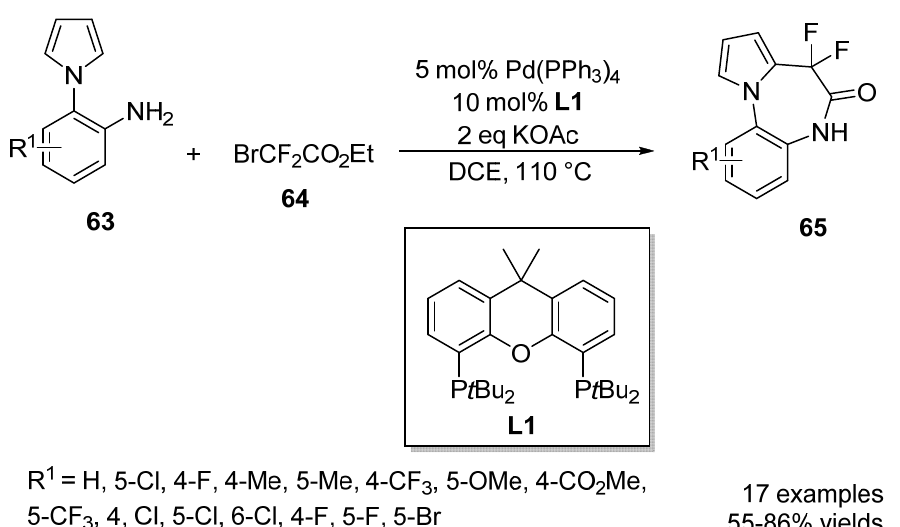
Scheme 30. Cascade reaction for the synthesis of difluoroalkylated pyrrolobenzodiazepines 65 .